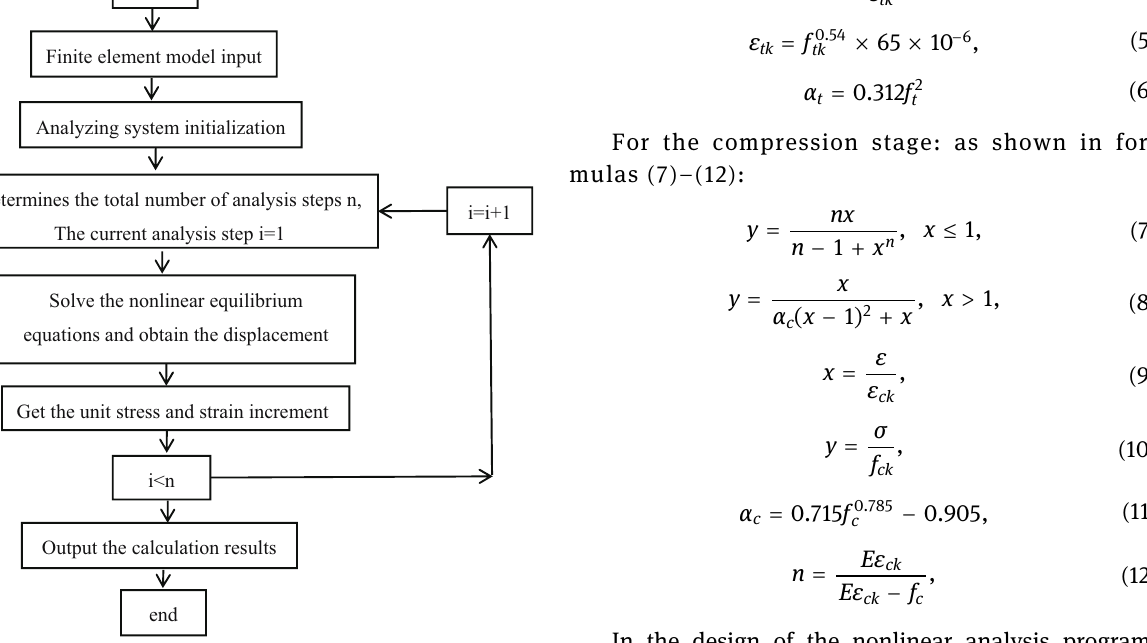
Figure 2: Nonlinear fi nite element analysis